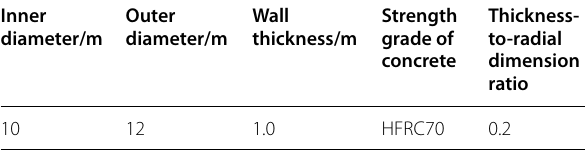
Table 9 Design parameters of prototype shaft wall structure.